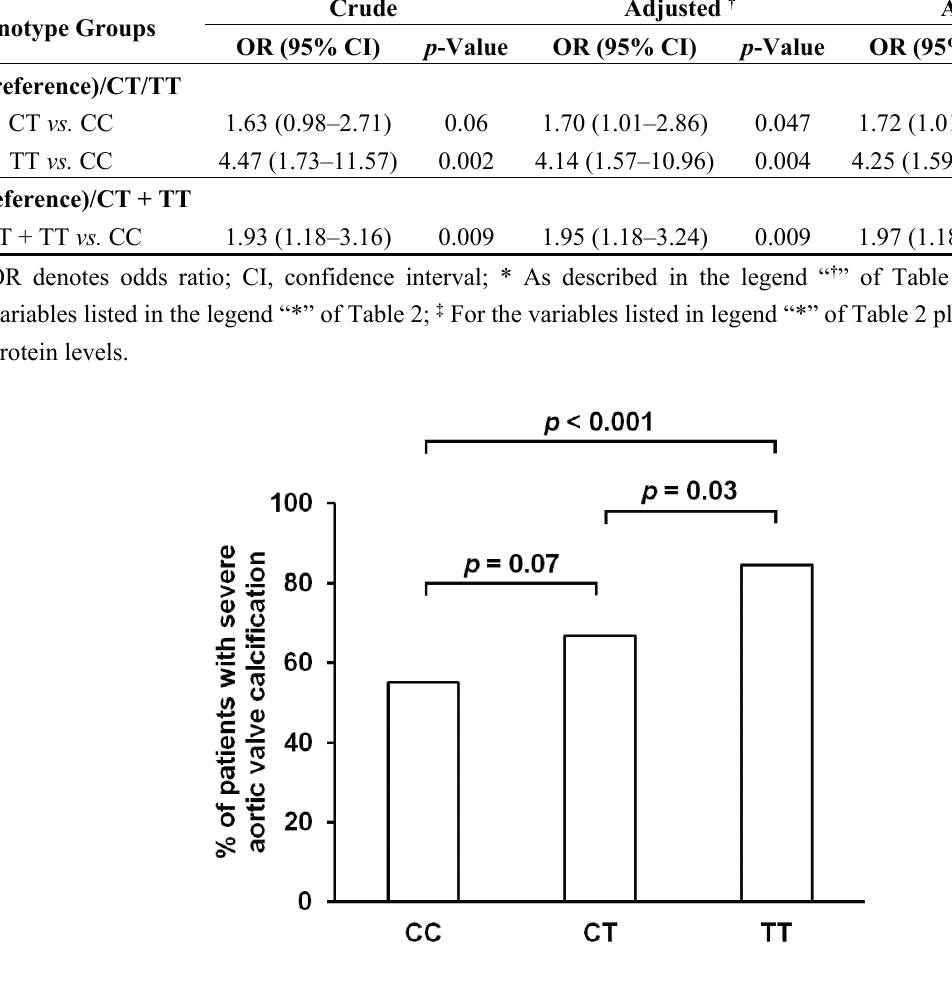
Figure 2. Percentage of patients with severe aortic valve calcification with regard to the genotype of plasma C-reactive protein ( CRP ) gene rs1205 C>T polymorphism.